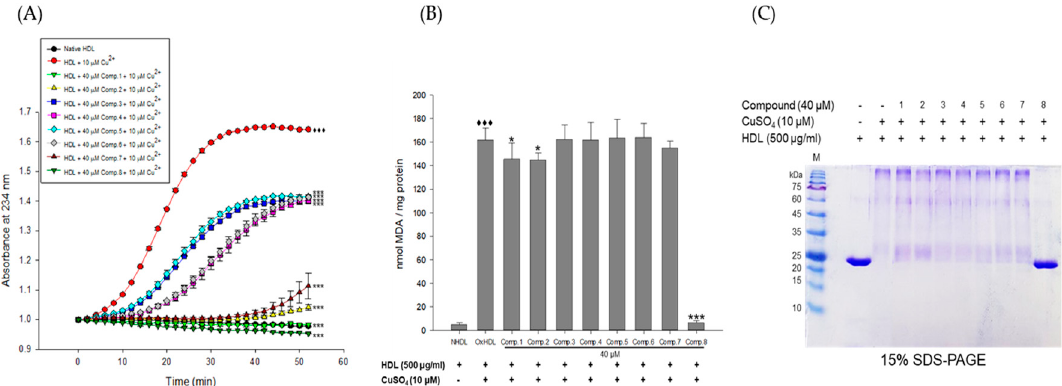
Figure 2. Effects of E. koreanum extract (EKE) on Cu 2+ induced HDL oxidation. ( A ) Continuous monitoring of conjugated diene levels by absorbance at 234 nm (A 234 ) during 10 μ M Cu 2+ - mediated HDL oxidation in the presence of E. koreanum extract (final concentrations, 10 and 100 μ g/mL). ( B ) Effects of E. koreanum extract (final concentrations, 10 and 100 μ g/mL) on TBARS production during HDL oxidation induced by CuSO 4 for 4 h at 37 °C. ( C ) SDS-PAGE of HDL modified by 10 μ M CuSO 4 for 4 h in the absence or presence of E. koreanum extract (final concentration, 10 and 100 μ g/mL). These data are expressed as mean ± SD of three independent experiments. ♦♦♦ , p < 0.001 vs. NHDL (native HDL); ***, p < 0.001 vs. OxHDL (oxidized HDL).